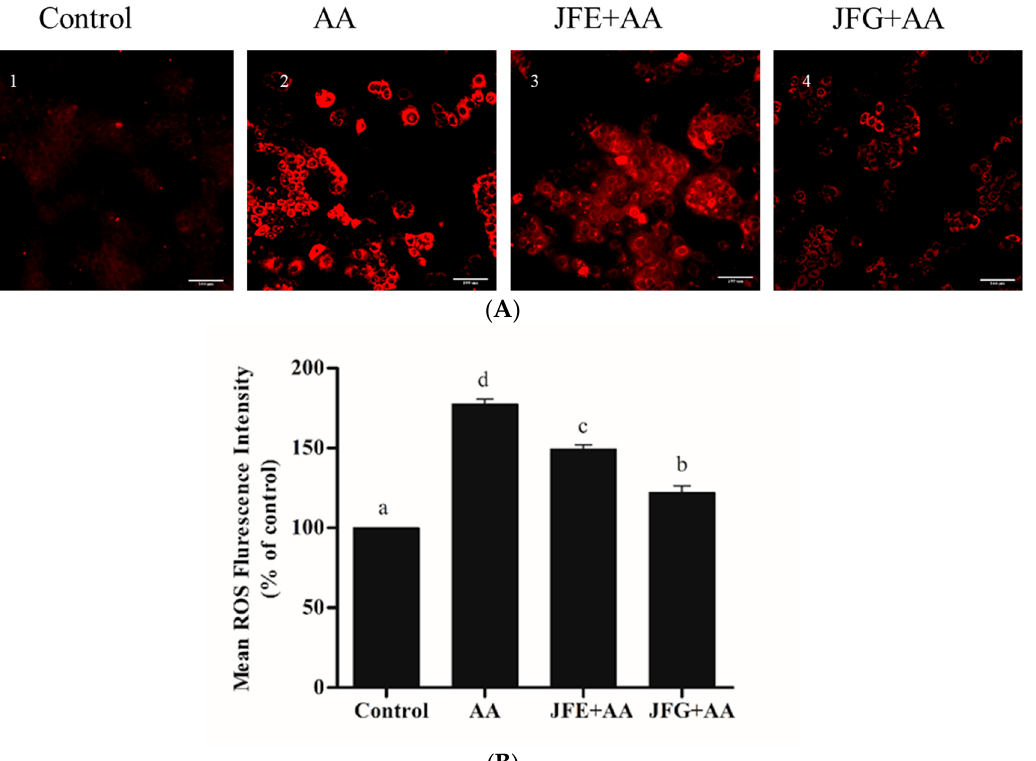
Figure 3. Deep red reagent which was located in the cytoplasm. ( A ) Caco-2 cells were treated with 2 g/L AA for 2 h, with or without 2 mg/mL JFE or JFG for 24 h, and photographed using HCA. Scale bars = 100 μm ( B ). The mean ROS fluorescence intensity of AA groups, JFE groups, and JFG groups, and the control groups (set to 100%). The data was expressed as mean percent (mean ± standard deviations), and different letters in the bars within each group represent statistically significant differences ( p < 0.05).